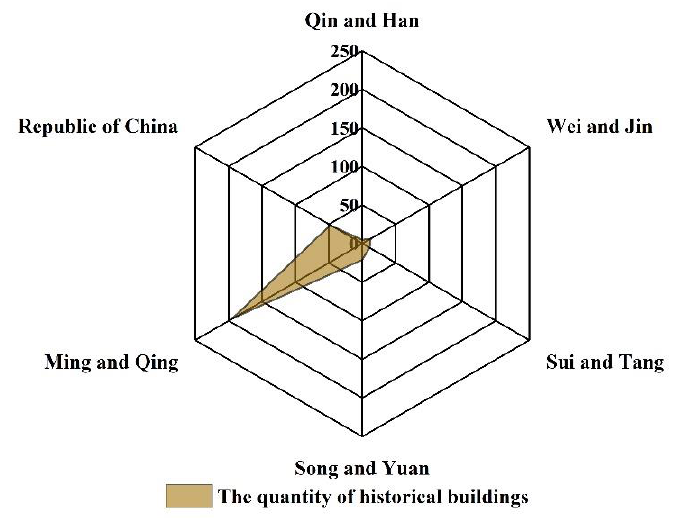
Figure 3. The quantity of historical buildings in the Songshan region in different periods. Table 1. Types and definitions of historical buildings.